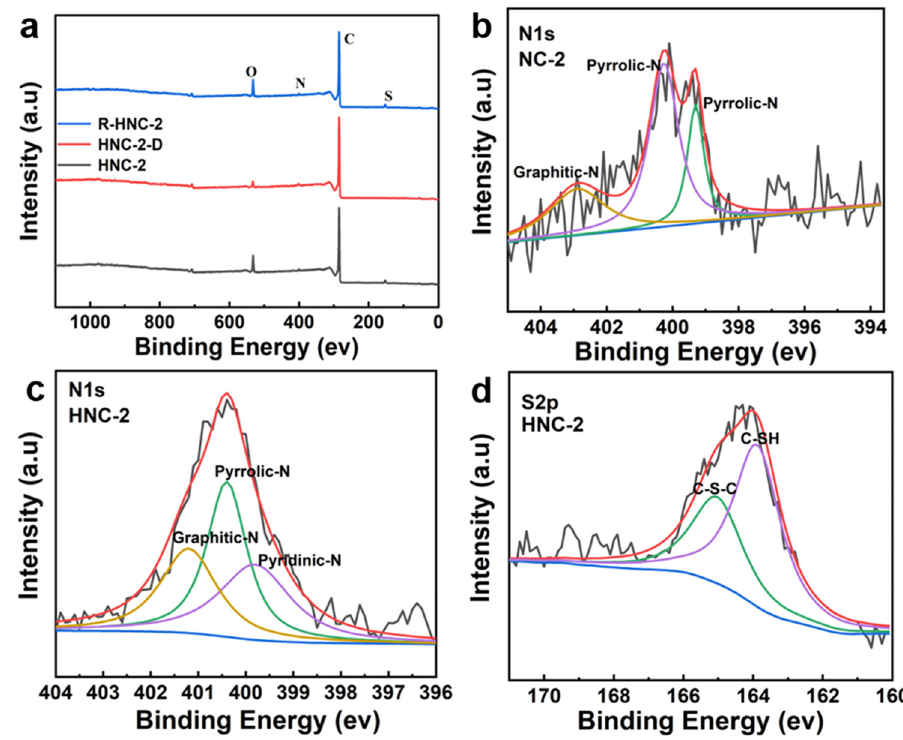
Figure 3: Spectra of HNC - 2, HNC - 2 - D, and R - HNC - 2: ( a ) total XPS, ( b ) N1s XPS of NC - 2, ( c ) N1s of HNC - 2, and ( d ) S2p of HNC - 2.